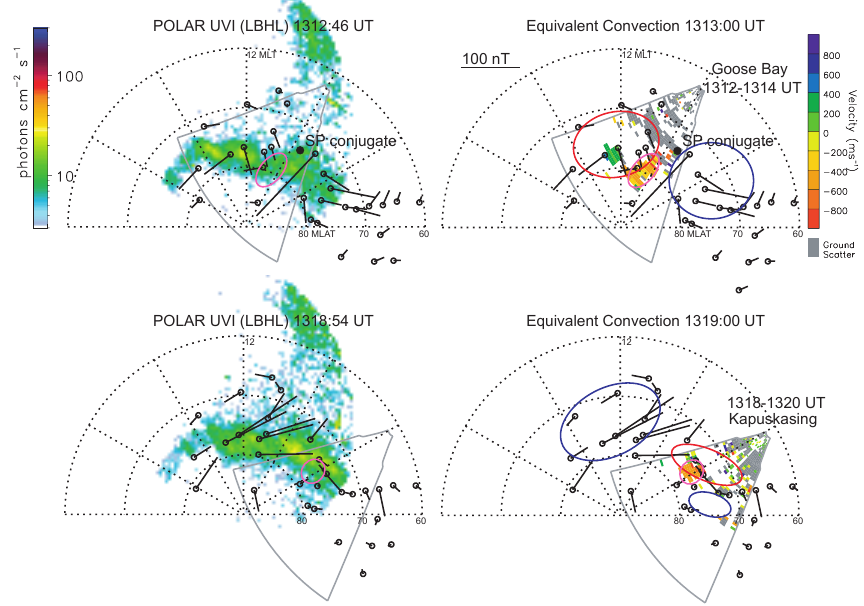
Fig. 1. Equivalent ionospheric convection velocities, POLAR-UVI auroral images, and SuperDARN Doppler velocities in the 24 July 1996 event. Equivalent ionospheric convection velocities derived from magnetometer data are shown by arrows (points away from circles) in the 22 May 1996 event in the polar map. Superposed color maps in the left panels are UV auroral intensity obtained by POLAR-UVI. The color-coded map of Doppler velocity is superposed in the right panels. SuperDARN field-of-view is shown with solid gray line. Red and blue ellipses indicate the subjective position of the clockwise and counterclockwise vortices, respectively. The cells of the “blob” structure are enclosed by pink ellipses. Conjugate points of the South Pole Station in Antarctica are indicated as the black circle with “SP conjugate”.